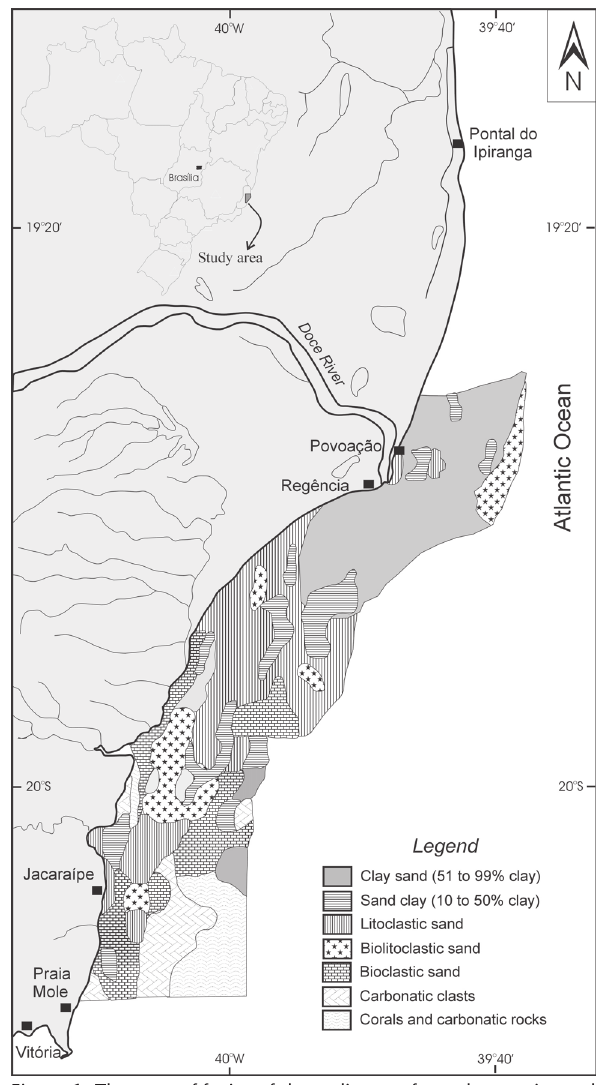
Figure 1. The map of facies of the sediments from the continental shelf between Vitoria and Povoação, near the Doce river mouth (after A LBINO & S UGUIO 2010). It show that bioclasts sediments pre- dominate in the southern region while sandy-muddy sediments are the majority at the northern